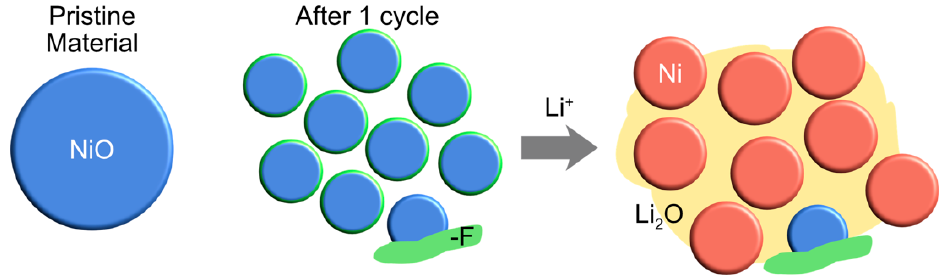
Figure 3. ( a ) EELS acquired from a part of pre-cycled NiO. SAED patterns and HAADF-STEM images obtained ( b , d ) before and ( c , e ) after in situ lithiation. In situ experiments were performed separately for the acquisition of SAED and HAADF-STEM.